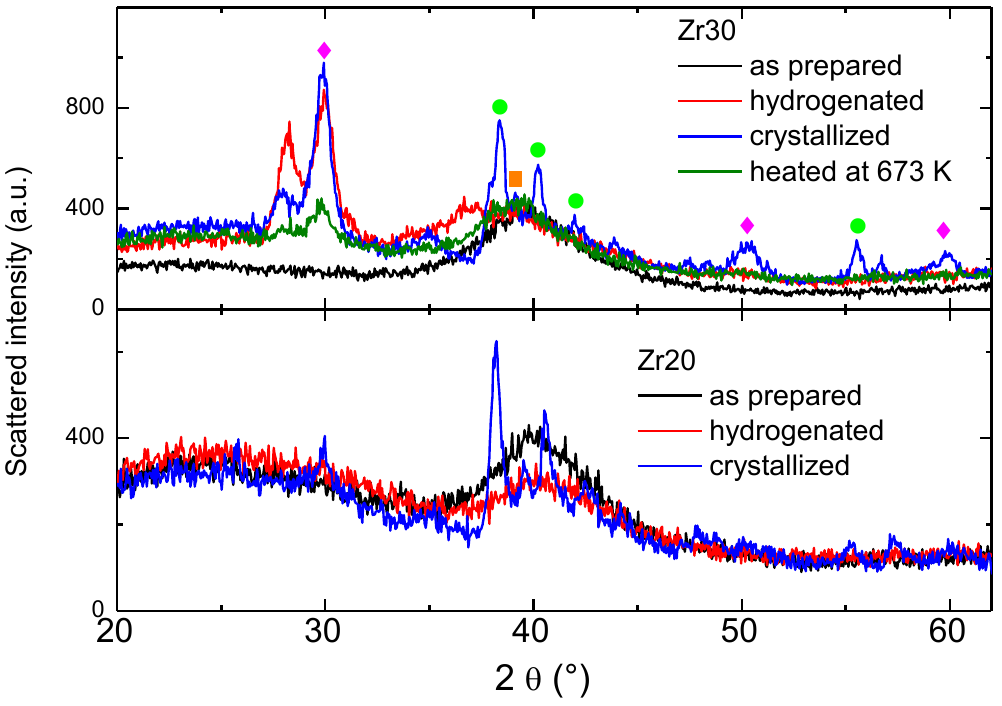
Figure 1. X-ray diffraction (XRD) spectra of all samples with attribution to crystalline phases (magenta diamonds: ZrO 2 ; green solid circles: Ni 10 Zr 7 ; orange squares: Ni 48 Zr 52 )